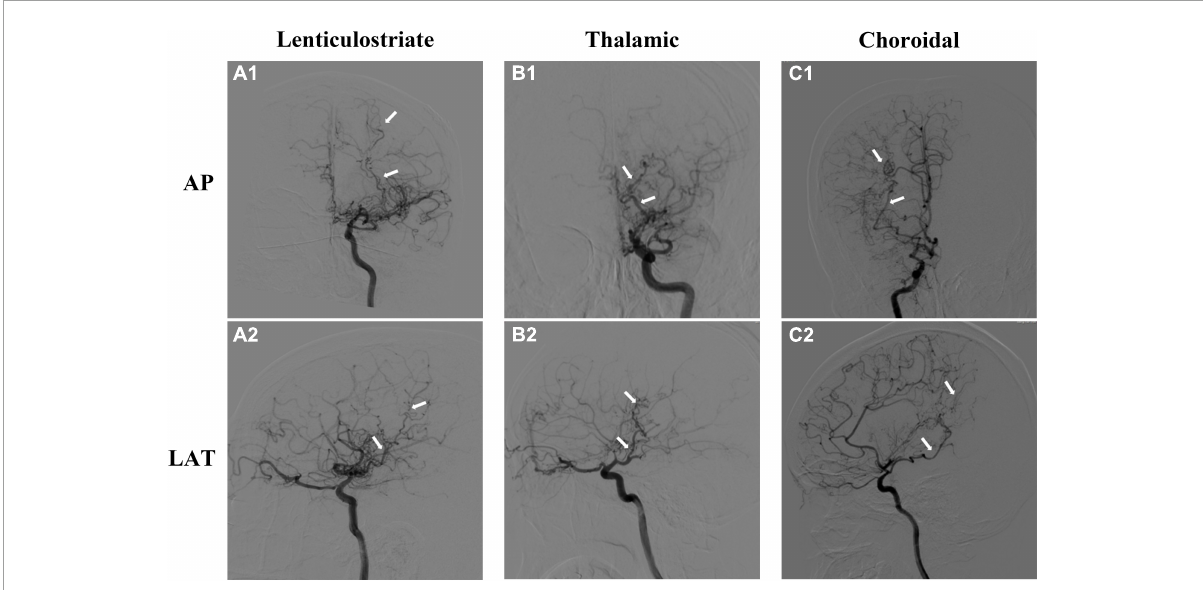
FIGURE2 Three types of moyamoya disease (MMD) collaterals. The upper is the anteroposterior (AP) view of angiographic images, and the lower is the lateral (LAT) view. (A1,A2) Lenticulostriate anastomosis; (B1,B2) thalamic anastomosis; (C1,C2) choroidal anastomosis. The dilated and extended arteries are labeled with white arrows.